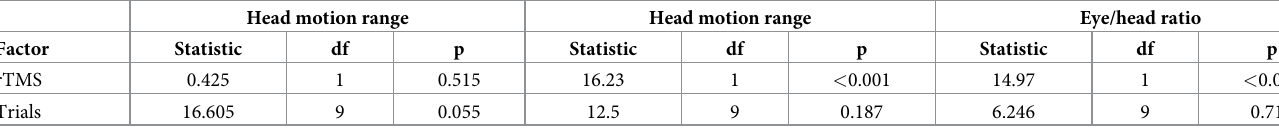
Table 2. Kruskal–Wallis test in % change.